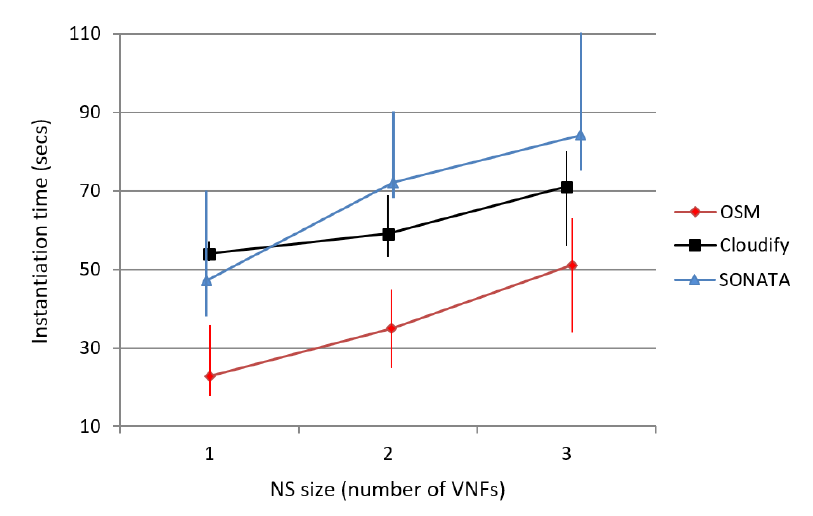
Figure 4. Average NS instantiation time